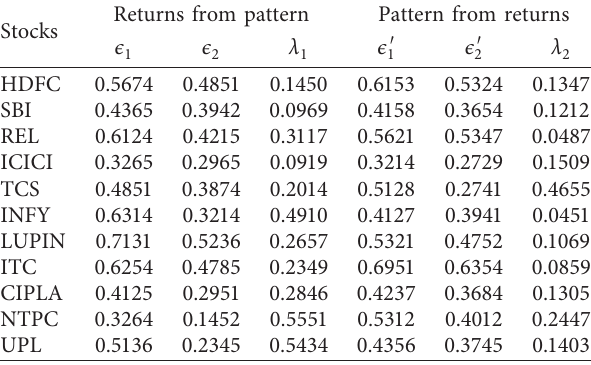
Table 10: Average prediction error reduction index of stocks for